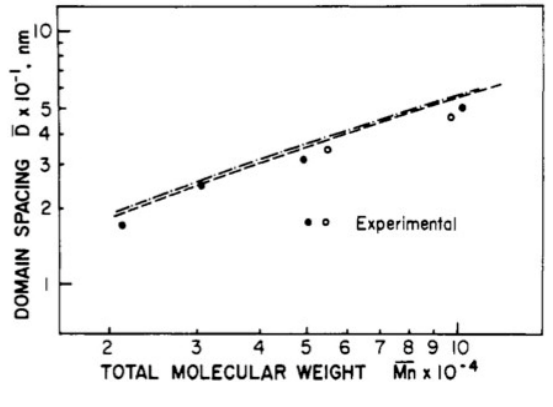
Figure 5. Effect of overall molecular weight on the measured domain spacing of a polystyrene-block-isoprene diblock copolymer [34]. Adapted with permission from [34]. Copyright 1980 American Chemical